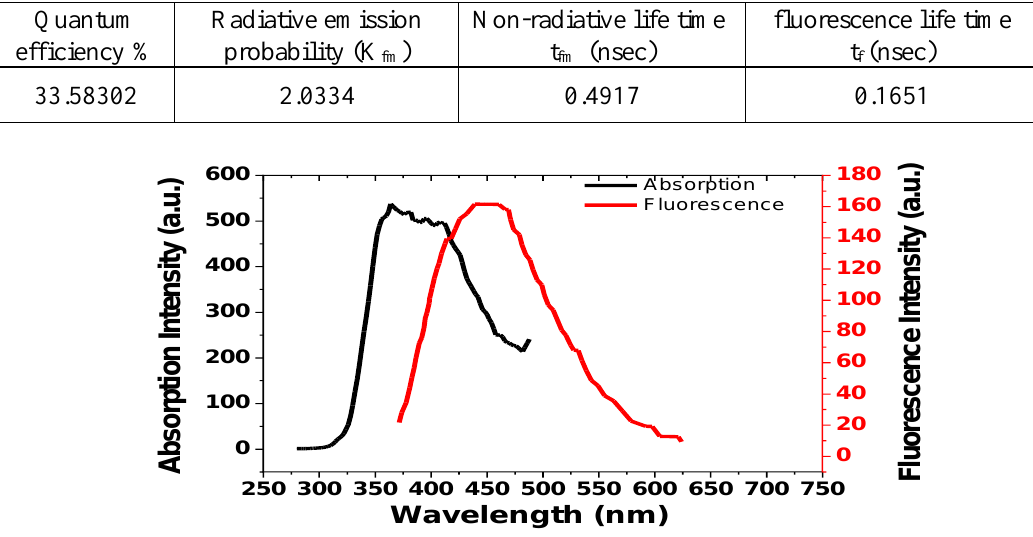
Figure 2: Absorption and Fluorescence spectrum of Vitamin D